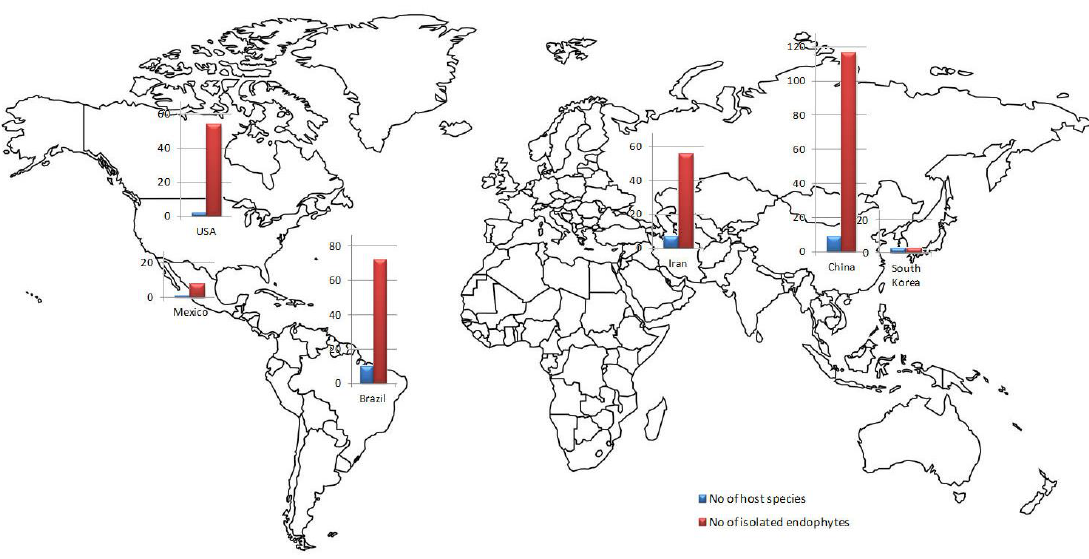
Figure 1. The Asteraceae hosts and endophyte fungi isolated from them in chosen countries (based on the references cited in this review).